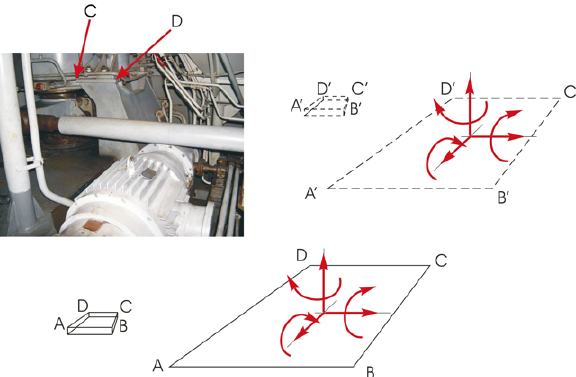
Figure 33: Rectilinear and rotational displacements applied to the joint brackets of the frame of the linear electromagnetic